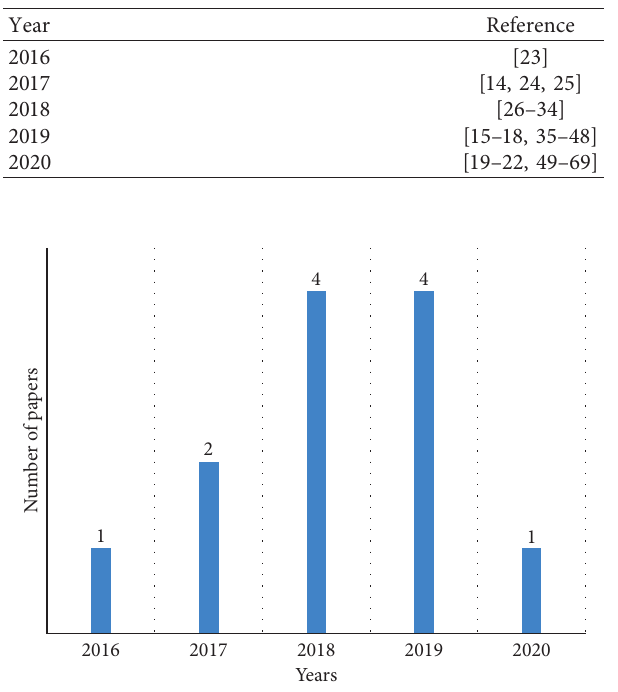
Figure 1: Papers published in the mentioned years.